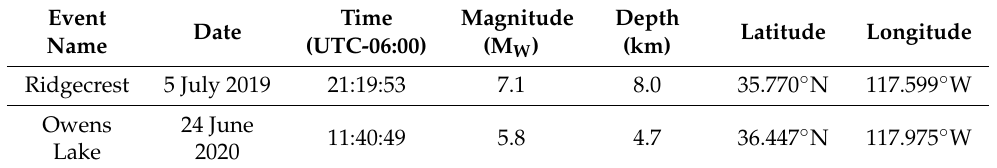
Table 1. Data on primary shocks of the Ridgecrest July 2019 and Owens Lake June 2020 earthquakes.